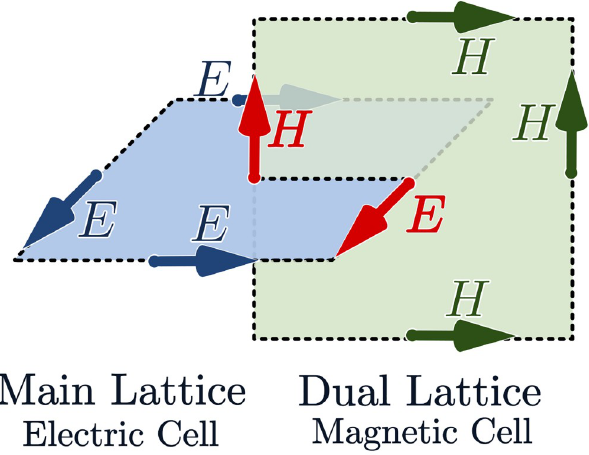
Fig 1. Arrangement of electromagnetic field components in a Yee’s cell. An FDTD mesh is formed by two lattices. Electric-field components are placed at the centres of cell edges of the primary lattice. Magnetic field components are located in a dual lattice, offset by half of a spatial step from the primary